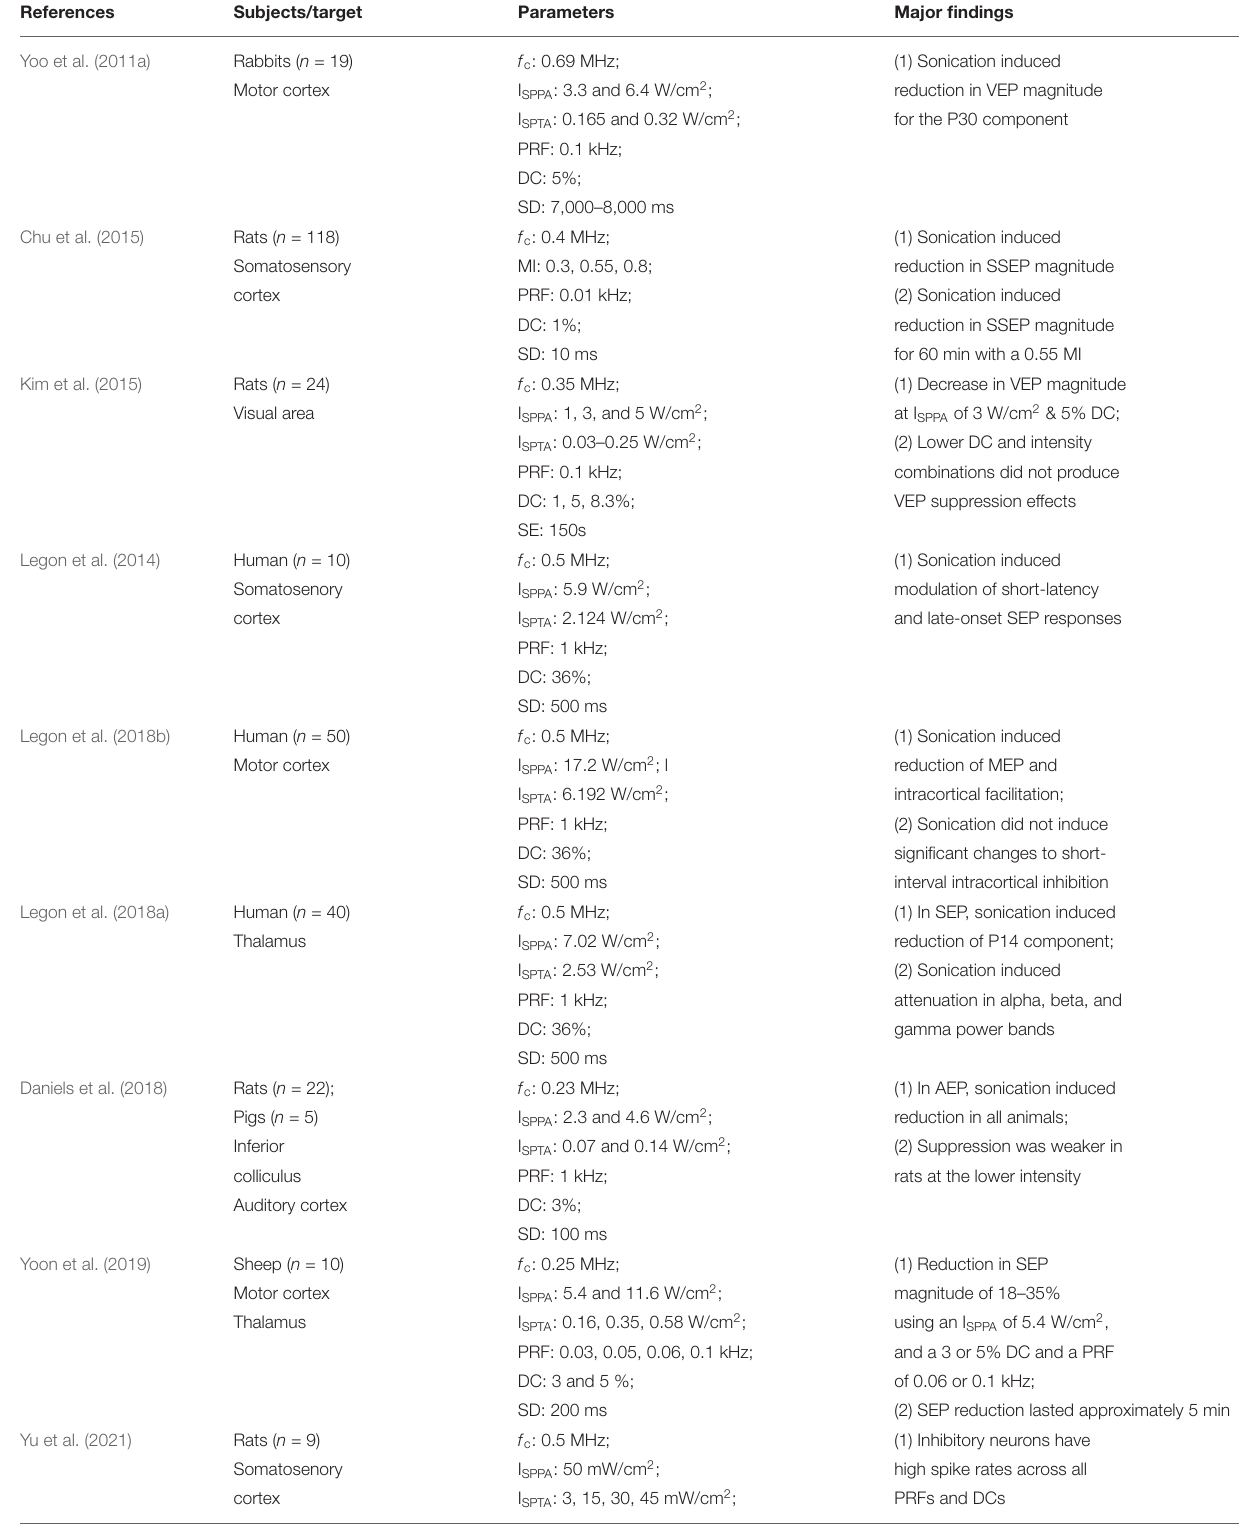
TABLE 2 | Suppressive findings for animals and